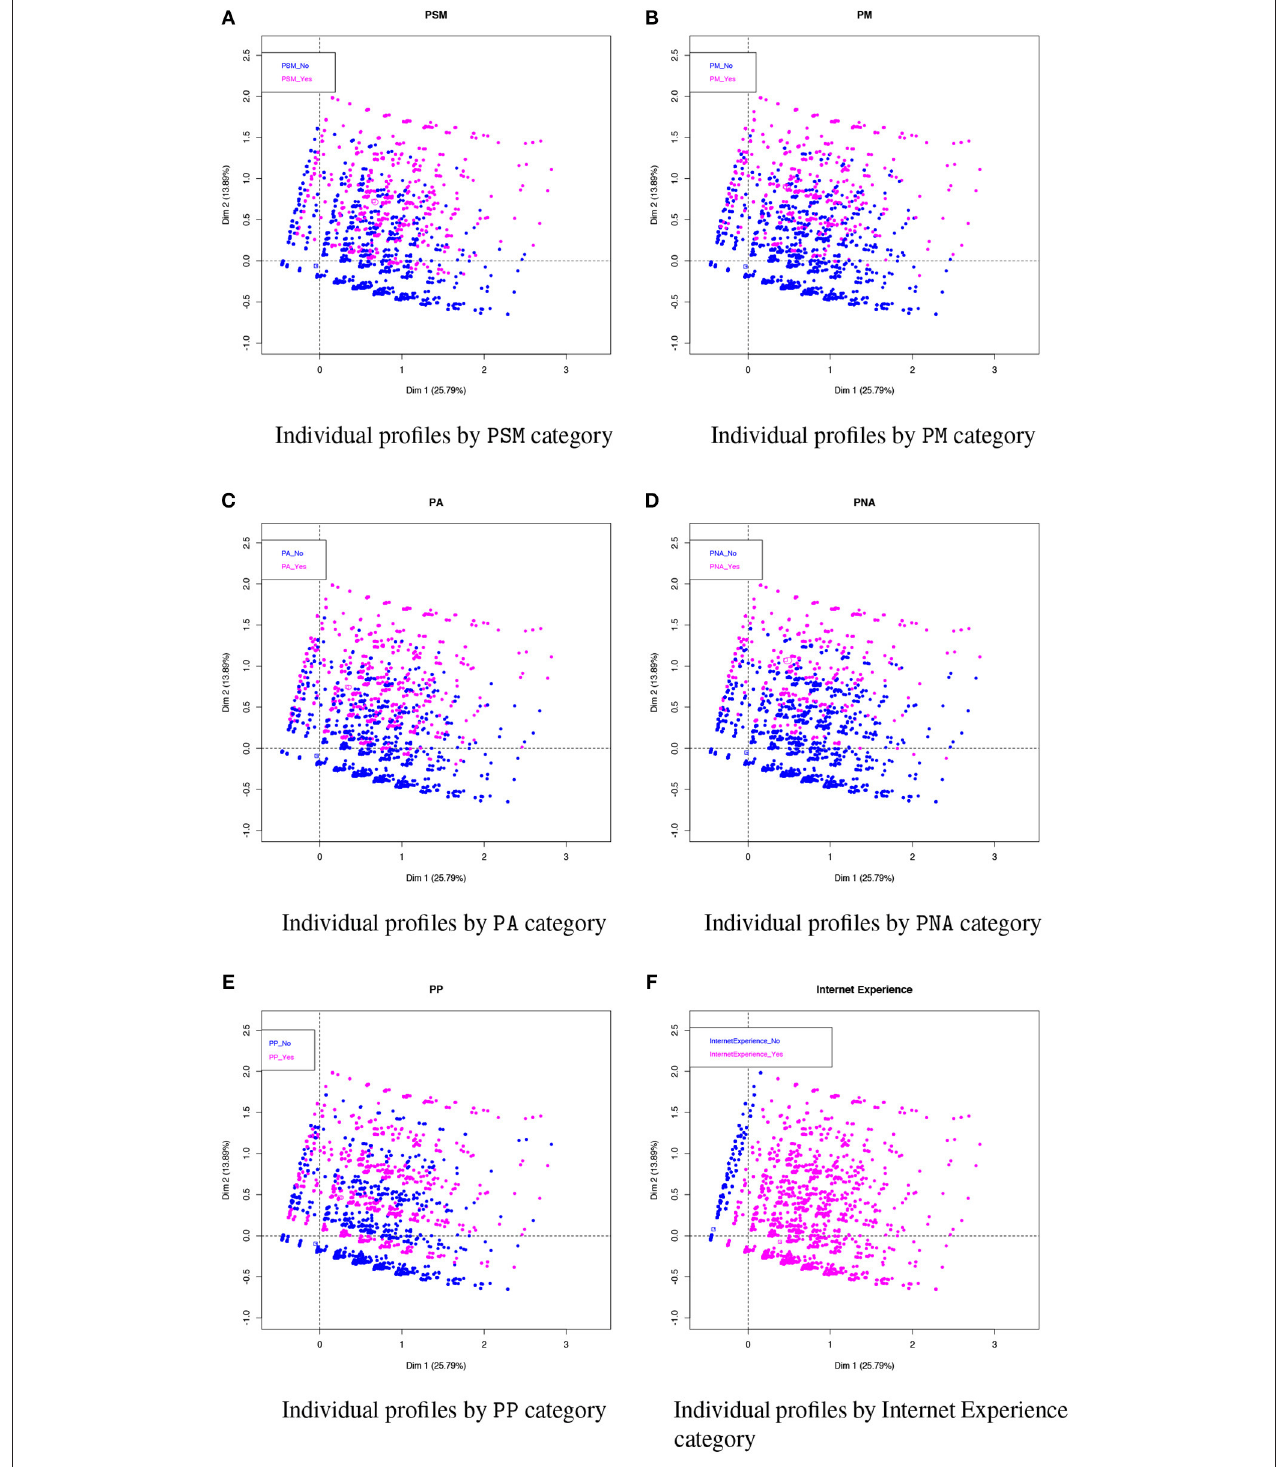
FIGURE 6 | Representation of individuals according to their participation in protest activities (i.e., (A) PSM , (B) PM , (C) PA , (D) PNA , and (E) PP ) and (F) Internet Experience ( n 19,050 =